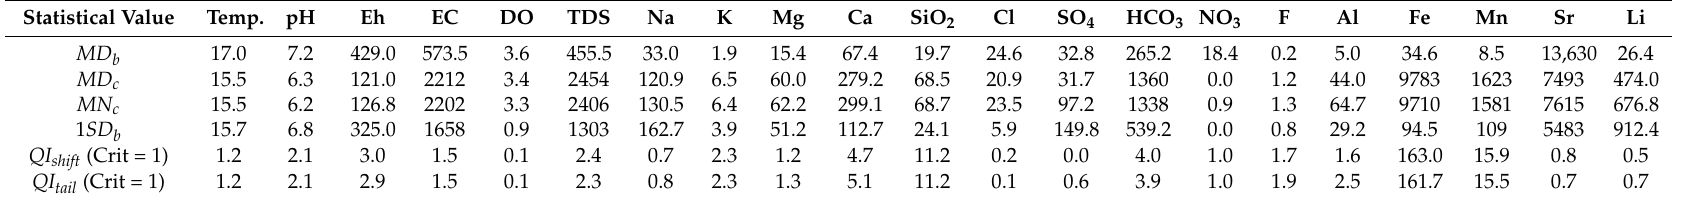
Table 7. Result of PDF verification for CO 2 -rich and ordinary groundwaters in Gyeongsang Province.